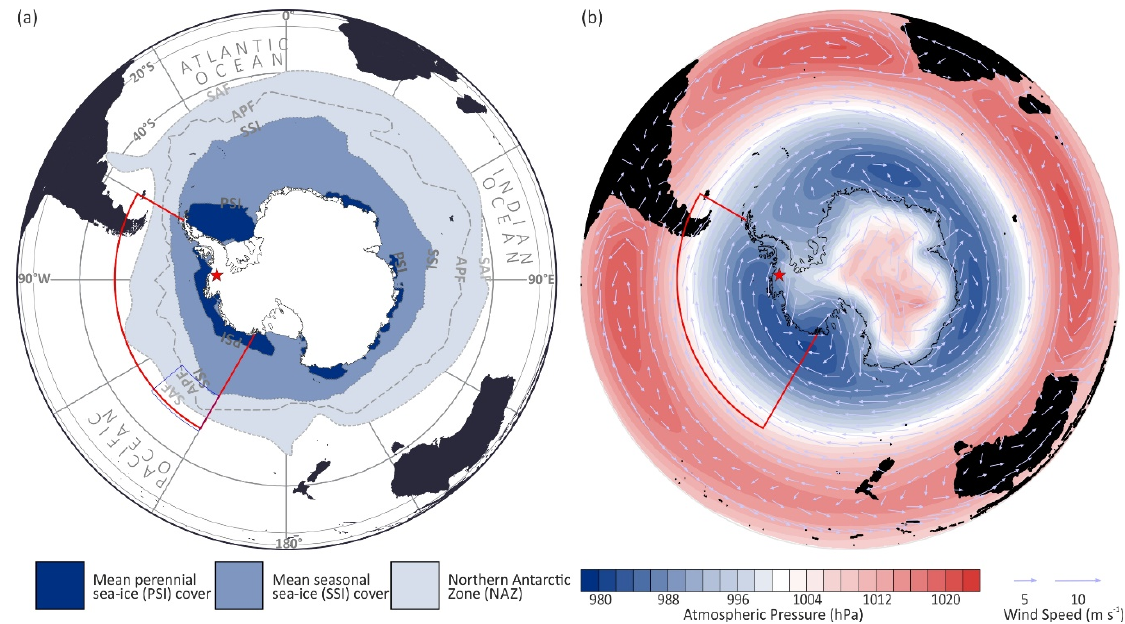
Figure 1. Southern hemisphere maps showing location of the Ferrigno ice core site (red star), the Amundsen and Bellingshausen Seas region (red outline) and the principal ( a ) oceanographic and ( b ) atmospheric features of the high southern latitudes. ( a ) Dashed grey lines mark the mean positions of the Subantarctic and Antarctic Polar Fronts (SAF and APF). Dotted grey lines indicate the mean extent of the seasonal and perennial sea-ice (SSI and PSI), calculated from daily remote sensed readings that have been averaged into monthly mean values and then into a single grid for the period 1981–2010 [46]. Shaded areas (from north to south) denote the Northern Antarctic Zone (NAZ; lightest), the mean SSI zone (mid-tone) and the mean PSI zone (darkest). ( b ) Arrows depict mean wind speeds (m s − 1 ) for the period 1979–2015 derived from the European Centre for Medium-Range Weather Forecasts (ECMRWF) Re-Analysis data (ERA-Interim) [47,48]. Red-to-blue shading represents mean atmospheric pressure at sea level (hPa). Darkest blue shading marks the low pressure fields, with the Amundsen Sea Low (ASL) dominating the southern Amundsen and Bellingshausen Seas.